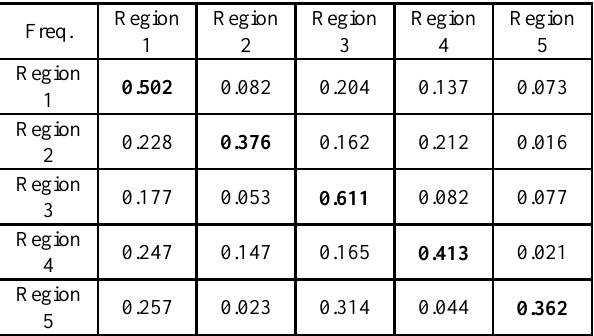
Table 2. The interaction frequency between regions: the interaction frequency within a region are much higher than that between regions.